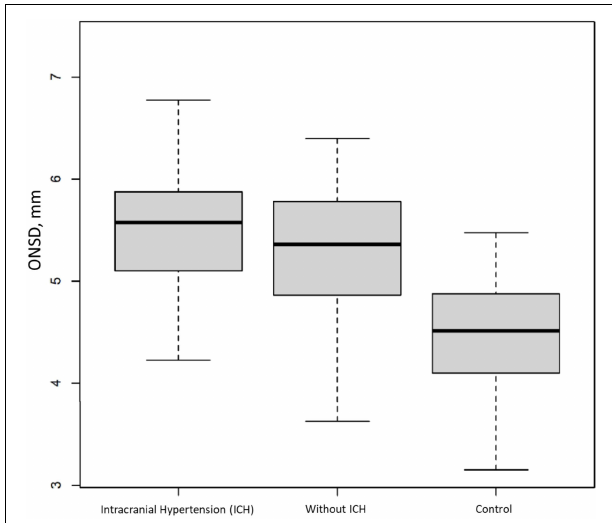
FIGURE 6 | Initial Optic Nerve Sheath Diameter (ONSD) in a paediatric brain injury population. Comparison between patients with or without Intracranial Hypertension (ICH) and the control group. Box and whisker plots represent interquartile range and 95% CI, respectively, and the horizontal bar indicates the